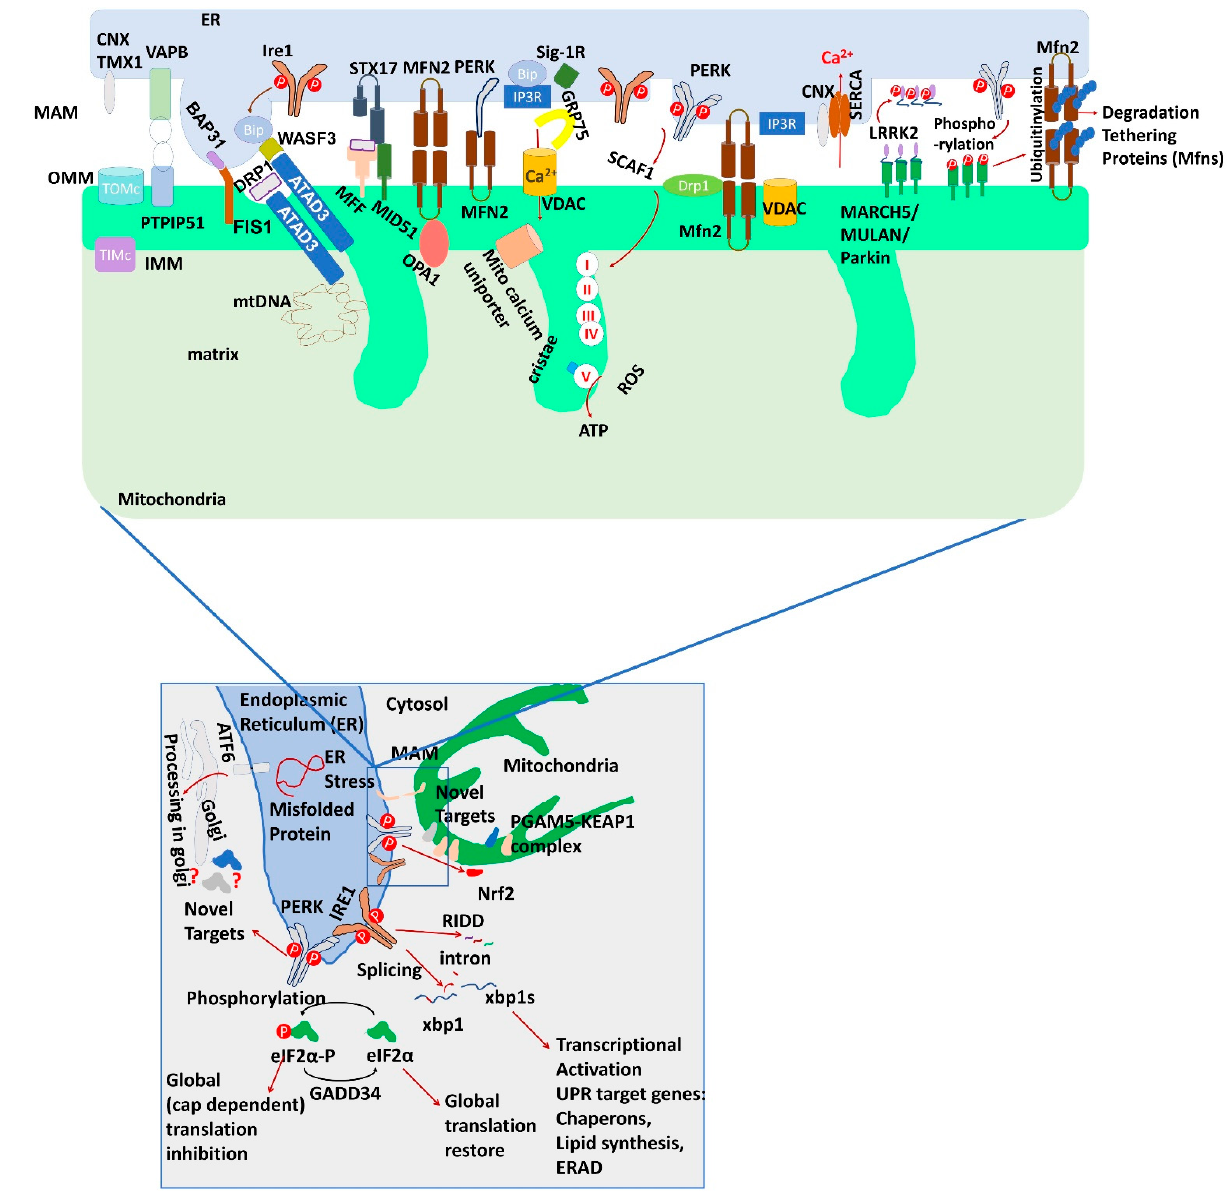
Figure 1. Endoplasmic reticulum (ER) mitochondrial contact: membrane dynamics, signaling and involvement of ER stress sensors. ( Top ), the schematic representation of ER-mitochondrial contact with key molecular contributors and their known functional interactions are summarized. MAM proteins are generally anchored either on the ER or outer mitochondria surface. Some MAM proteins like ATAD3A span from the inner mitochondrial membrane to ER -Mito contact site. Calcium transfer between ER-Mitochondria regulates through different channel proteins distributed throughout the MAM site. IP3R on the ER membrane transfers calcium from ER lumen to the mitochondria which is mediated by GRP75 and is taken up by VDAC at OMM and transferred to IMM via MCU. SERCA formulates the return of calcium to ER. SIGMA 1R protects IP3R from ERAD. TIMC/TOMC, protein translocase complexes of IMM and OMM mediating mitochondrial protein import. TMX-1 at MAM forms a functional complex with Calnexin (CXN) and SERCA to modulate calcium flux. VAPB an ER integral membrane protein and PTPIP51 an OMM protein interact with each other to regulate lipid transfer. MFN2 in ER and mitochondria/ MFN1 in mitochondria are tethering proteins which can also regulate calcium homeostasis. MAM proteins, LRRK and PERK control ubiquitination pathway dependent mitochondrial tethering process. MARCH5/MULAN/PARKIN modulates the structure of MAM through degradation via LRRK mediated MFN2 ubiquitinoylation. Mitochondrial dynamics are maintained by the fission fusion process. Successful mitochondrial